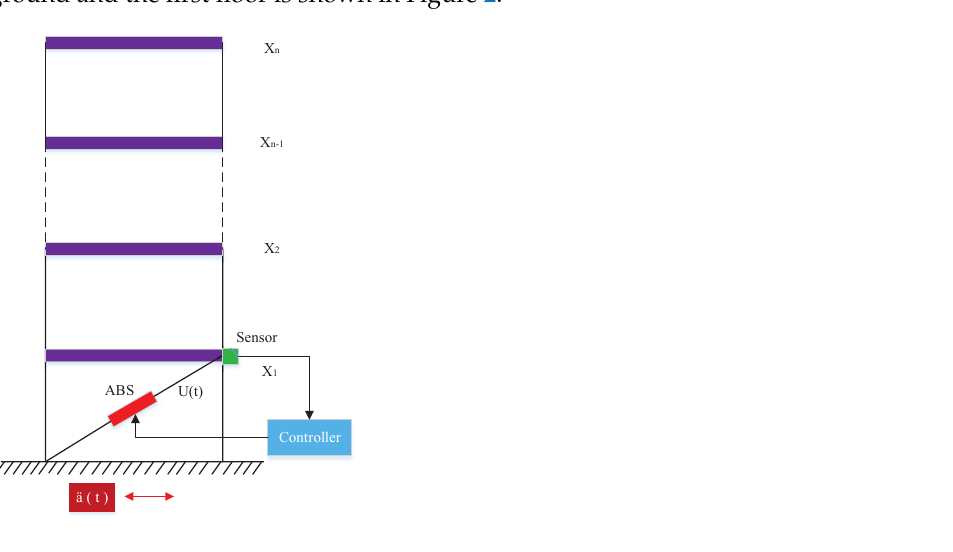
Figure 2. The n -DOF shear frame equipped with an ABS between the ground and the first